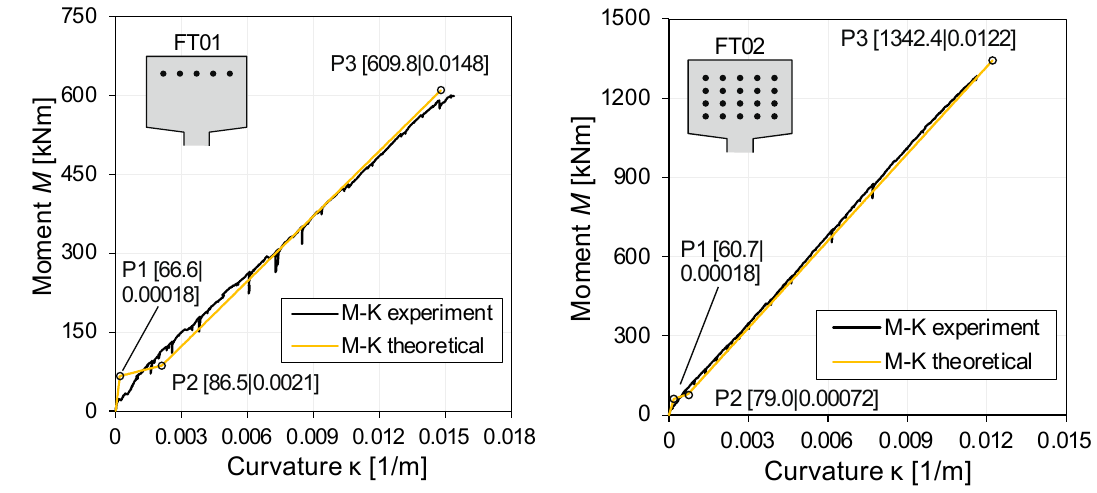
κ curve for FT01 ( left ) and FT02 ( right